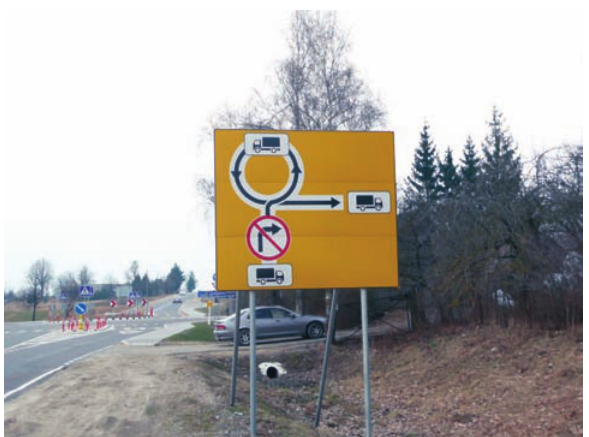
Fig. 7. The roundabout where the heavyweight vehicles are not able to make the right